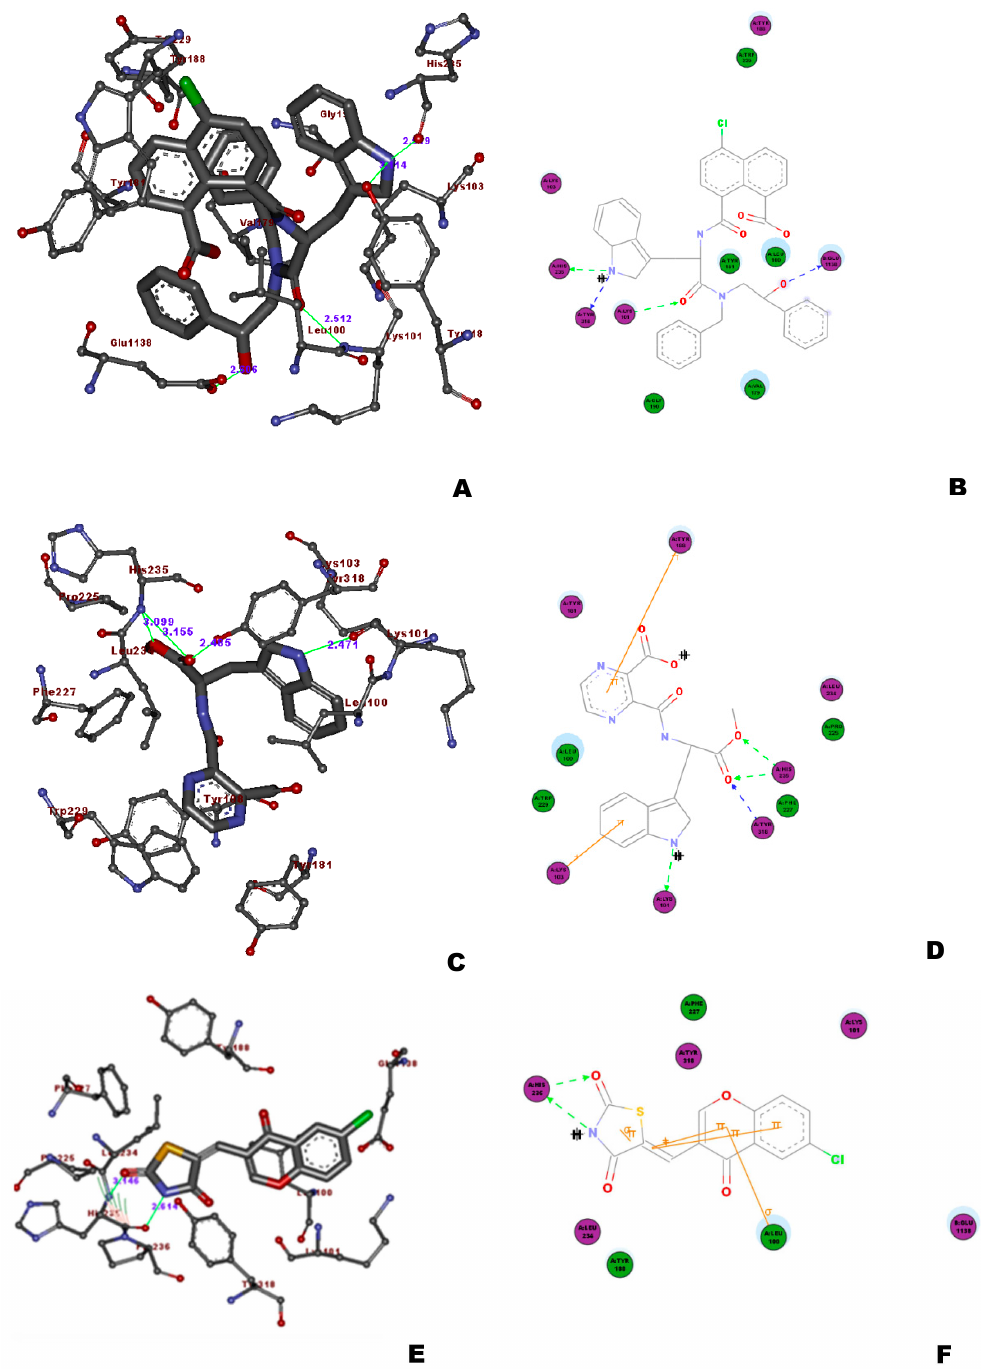
Figure 7. The molecular interactions of the ( A , B ) Core I compound 112 , ( C , D ) core II compound 114 , and ( E , F ) core III compound 128 in the binding site of HIV-RT using the PDB ID: